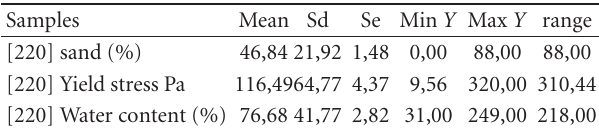
Table 1: Measurements data.